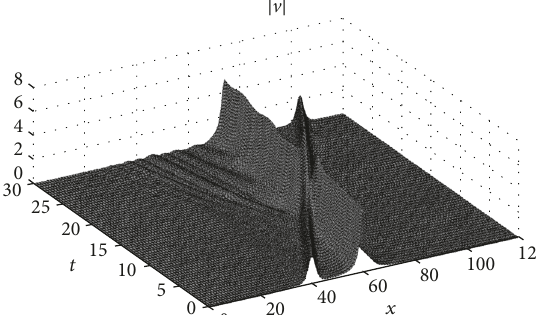
Figure21:Viewintheplane 𝑥 - 𝑡 ofthecollisionoftwosolitarywaves of the SBO system with velocities 𝑐 = 0.5 and 𝑐 = 2 . Observe that the colliding waves have different initial amplitude.